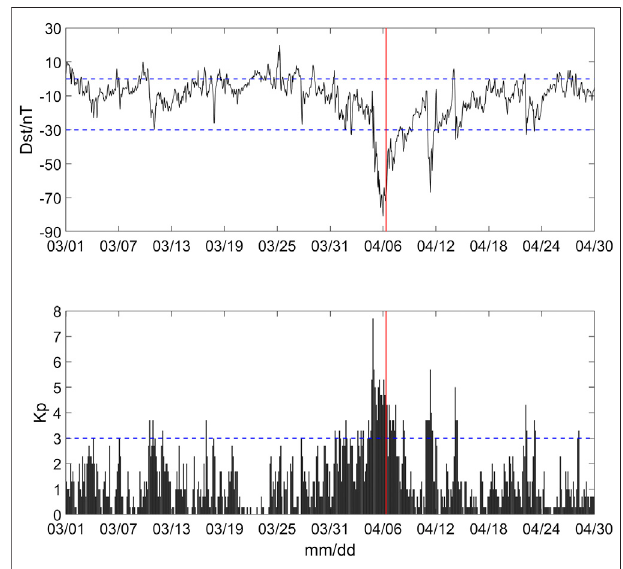
FIGURE2| Thegeomagnetic fi elddisturbanceindexfromMarchtoApril 2010 (top: Dst, bottom: Kp). The vertical red lines represent the occurrence of the main shock. The horizontal dashed blue lines represent the thresholds for data selection applied in the study (for more details, see the main text).